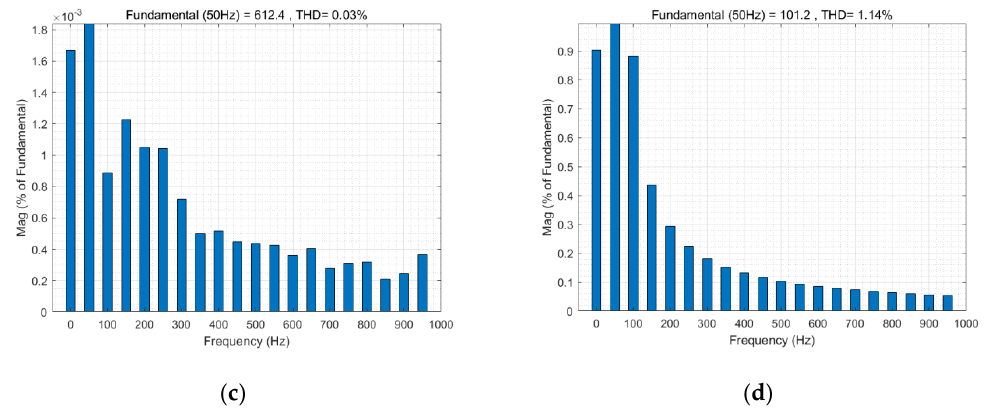
Figure 14. Simulation results of the AC side voltage and the current in the self-synchronization: ( a ) the output a -phase voltage v a ; ( b ) the output a -phase current i a ; ( c ) harmonic analysis result of the output a -phase voltage v a ; and ( d ) harmonic analysis result of the output a -phase current i a . Simulation conditions in grid-connected mode: